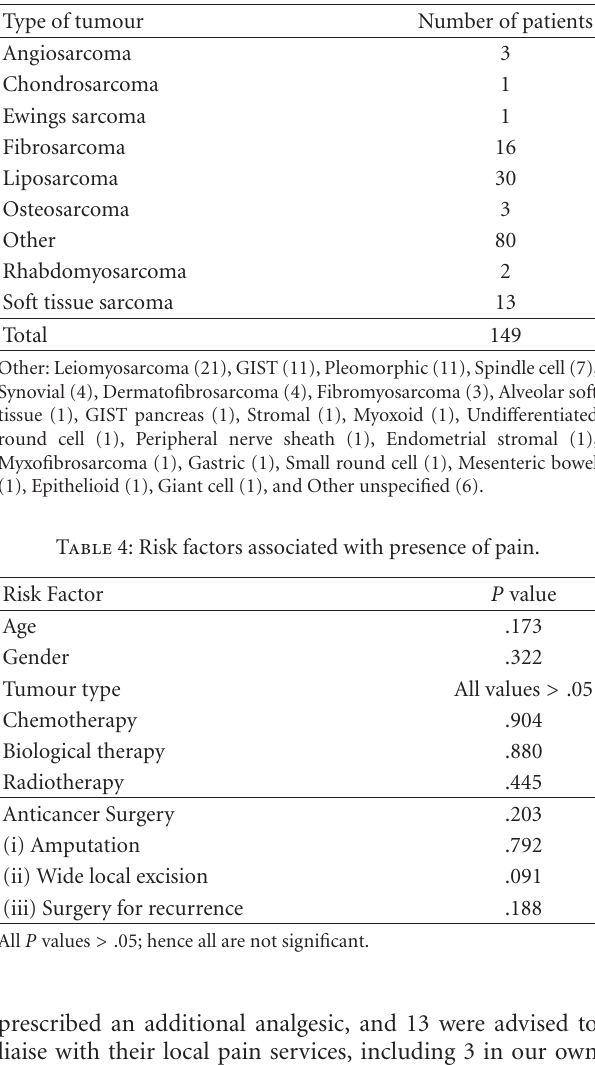
Table 3: Types of tumour.